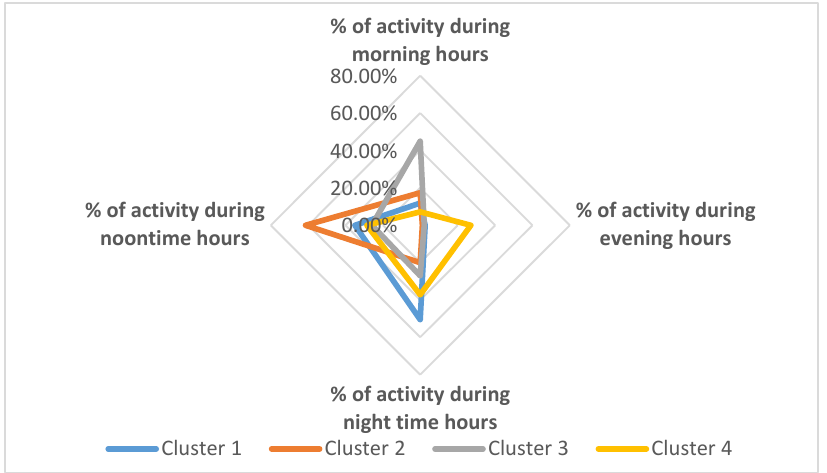
Figure 3 . Patterns of use of the flexibility of learning time during the